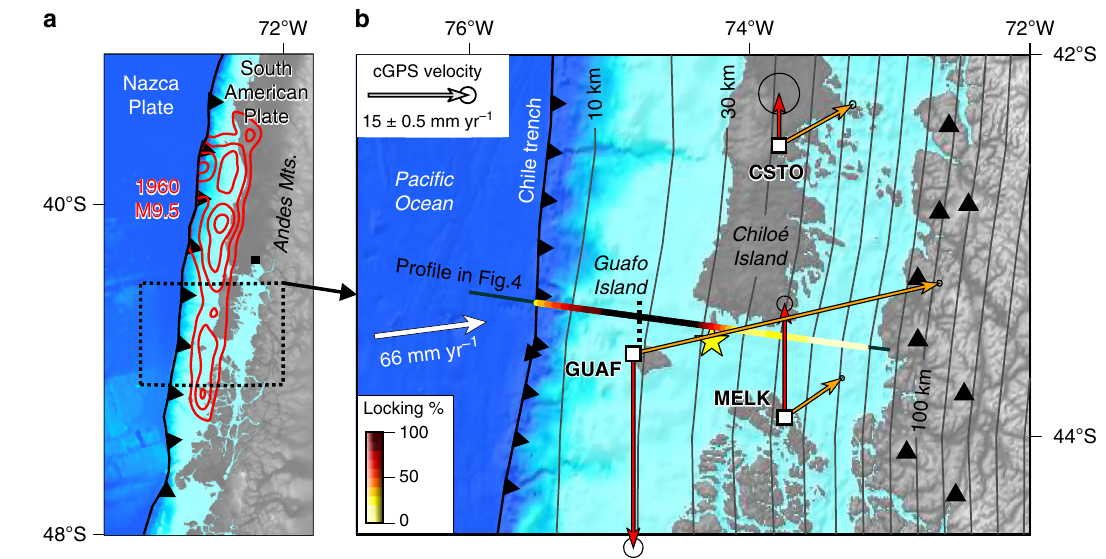
Fig. 1 Tectonic setting of the 1960 Chile earthquake. a Megathrust slip contours 60 (red lines, 10-m interval). Black square shows location of Puerto Montt. b Arrows show vertical and horizontal velocities from continuous Global Position System (cGPS) stations with respect to a stable South American reference frame (Methods; time series in Supplementary Fig. 10). Yellow star shows epicenter of the 2016 Chiloé earthquake 30 . Triangles denote active volcanoes. White arrow shows plate convergence vector estimated from space geodesy. Interseismic plate locking estimated from inverse modeling of cGPS velocities expressed as percentage of plate convergence rate (Methods). Dark gray contours show 10-km depth intervals to the top of the subducting slab 36 . Note that the downdip limit of interseismic plate locking occurs at depths of ~30 – 35 km. Bathymetry and topography from srtm15plus data 64 (available from